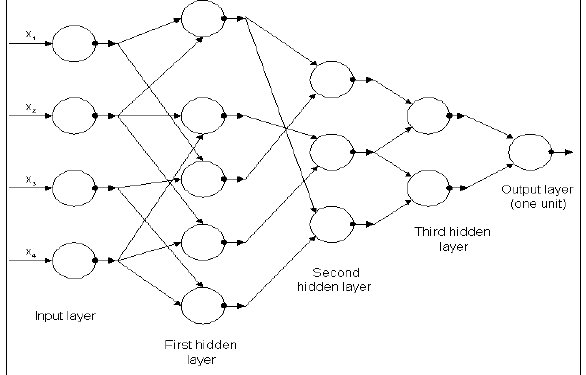
Figure 2. An example of a neural network